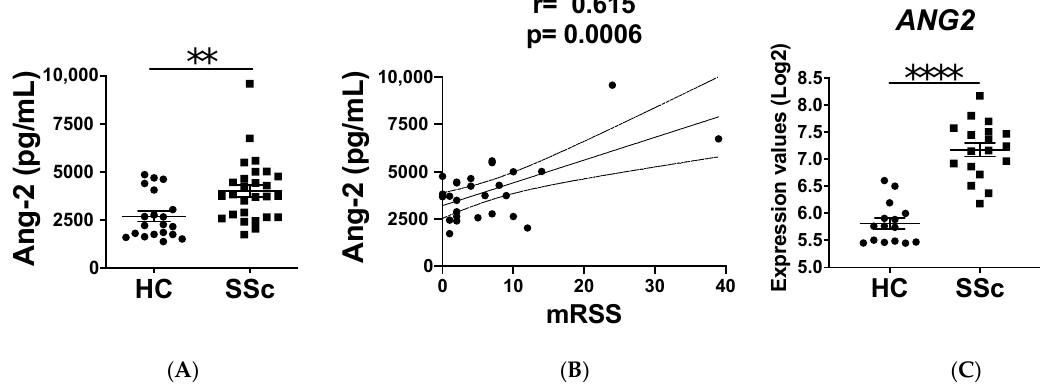
Figure 1. ( A ) Angiopoietin-2 (Ang-2) levels are elevated in systemic sclerosis (SSc) patients. Ang-2 levels in the serum of healthy controls (HCs) ( n = 20) and SSc patients ( n = 27). ( B ) Correlation of Ang-2 serum levels with modified Rodnan skin score (mRSS). ( C ) ANG2 expression in the skin of HCs ( n = 15) and a ff ected skin of dcSSc patients ( n = 18). Means and standard error mean (SEM) are shown. ** p < 0.01 and **** p < 0.0001.